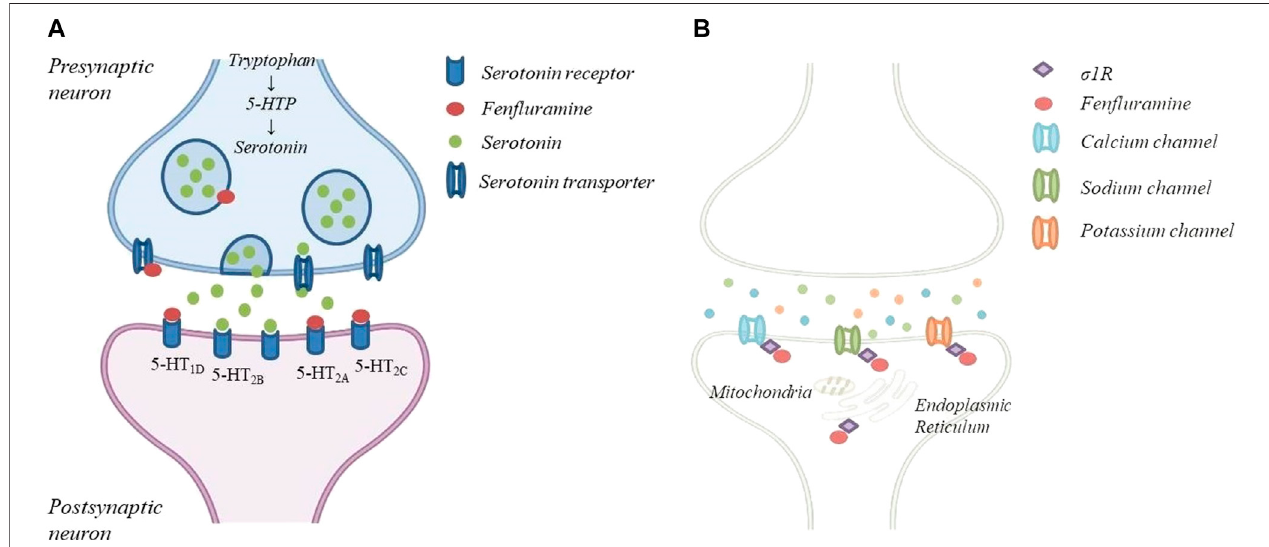
FIGURE1| ThemechanismofactionofFFA: (A) FFAcausesthereleaseofserotoninbydisruptingvescicularstorage,reversingserotonintranspoterfunctionanda agonist of speci fi c serotonin receptor; (B) FFA can regulate the activity od 1R located in the mitochondria-associated endoplasmic reticulum and several ion